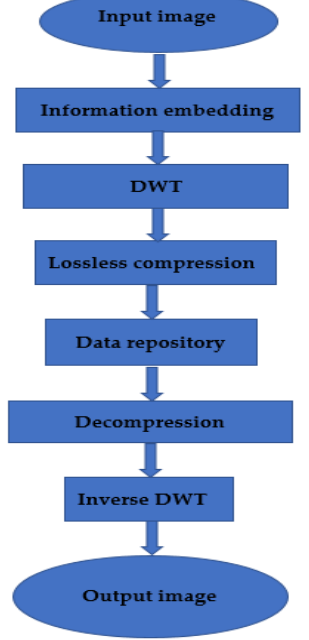
Figure 1. Overview of the architecture.